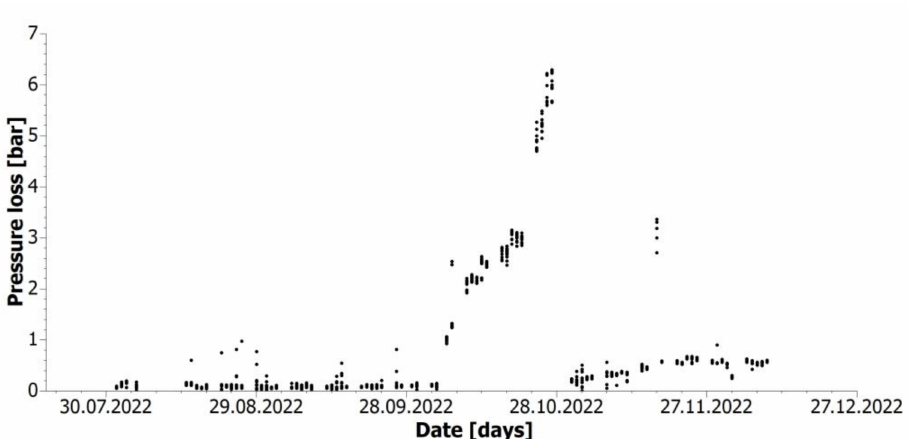
Figure 8. HEX-1 TMW pressure loss during